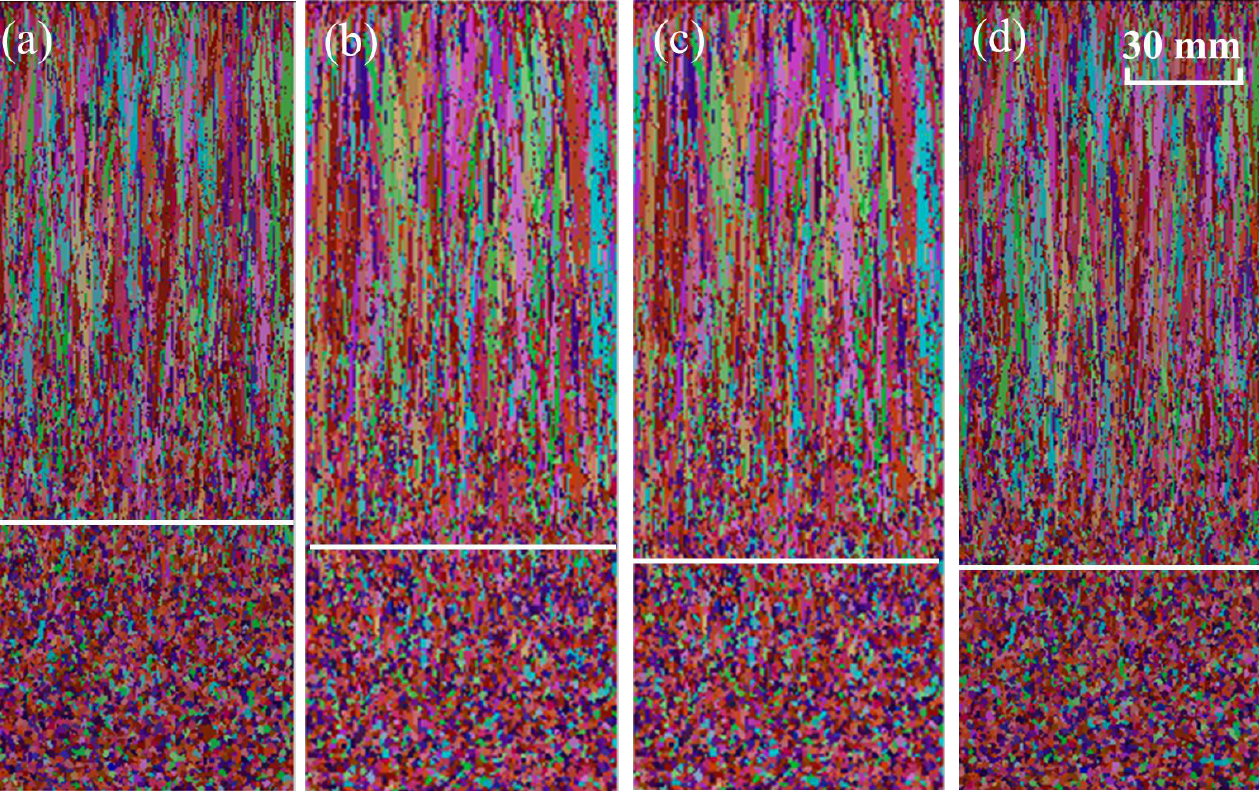
Figure 10. Simulated solidification structures under different specific water flow: ( a ) 0.28 L·kg −1 ; ( b ) 0.32 L·kg −1 ; ( c ) 0.36 L·kg −1 ; ( d ) 0.40 L·kg −1 . (Different colors in figure represent grain orientation)